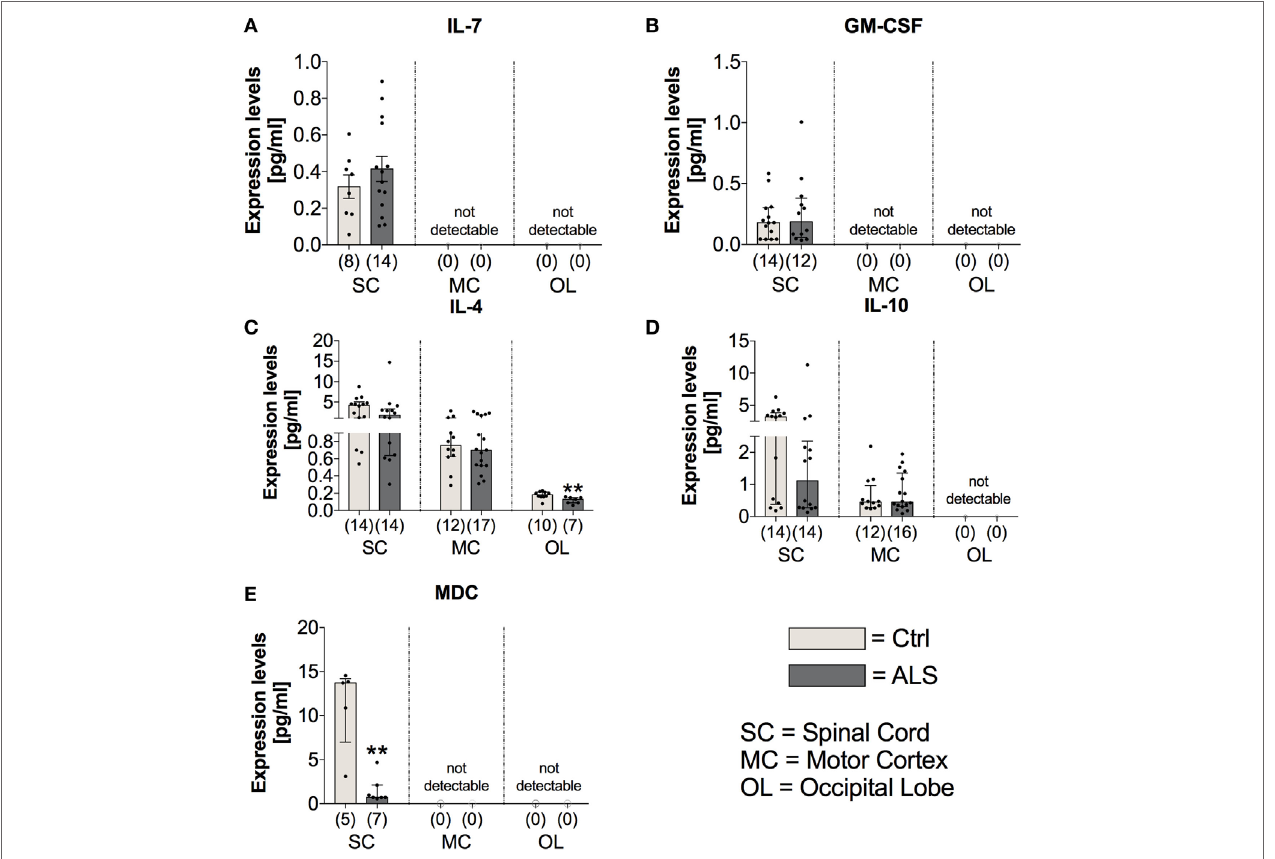
FigUre 9 | Tissue concentrations of anti­inflammatory cytokines and chemokines. In Amyotrophic lateral sclerosis (ALS) patients tissue, the expression levels of IL­7 (a) and GM­CSF (b) , both mediating and promoting proliferation of hematopoietic stem cells, were unchanged in the spinal cord (SC) of the two groups and not detectable within the motor cortex (MC) and the occipital lobe (OL). There was a reduced expression of the anti­inflammatory cytokine IL­4 within the OL of ALS patients and the spinal cord (SC) and the MC being unaffected (c) . The expression profile of the second anti­inflammatory cytokine IL­10 was unchanged for the two groups within the SC and MC and below detection threshold within the OL (D) . The anti­inflammatory chemokine MDC was significantly reduced within the SC of ALS patients compared to healthy controls (Ctrl). There were no detectable amounts in the MC or the OL (e) . ** p < 0.01 vs. Ctrl. Numbers of patients are given in brackets; All parameters were tested for Gaussian distribution using D’Augostino­Pearson omnibus normality test. Two­tailed Mann–Whitney test for GM­CSF, IL­4, IL­10, and MDC, data represent median with interquartile range; two­tailed unpaired Student’s t ­test for IL­7, data represent mean ±